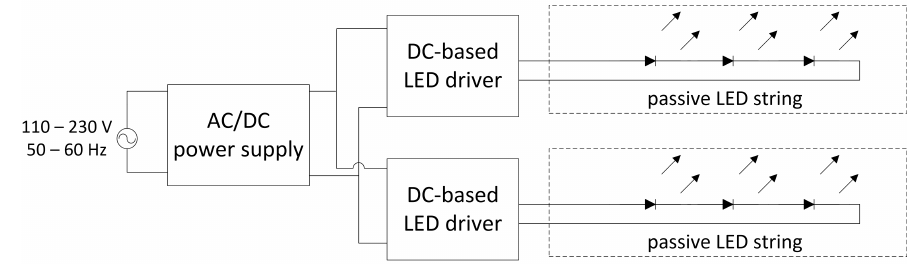
Figure 5. LED lamps with external drivers operating on a DC